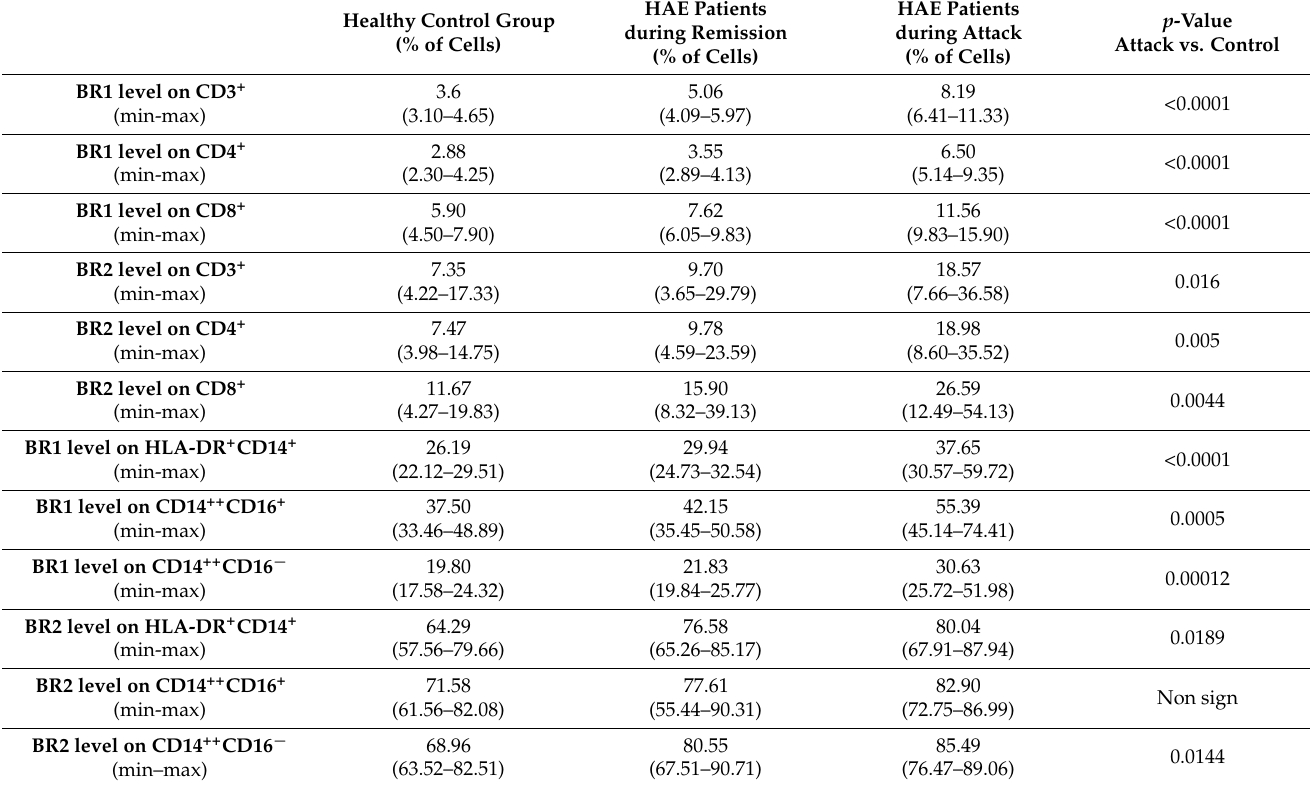
Table 2. Median of bradykinin receptors 1 and 2 expression on lymphocytes and monocytes. Statistical significance of the results was analyzed with a Mann–Whitney